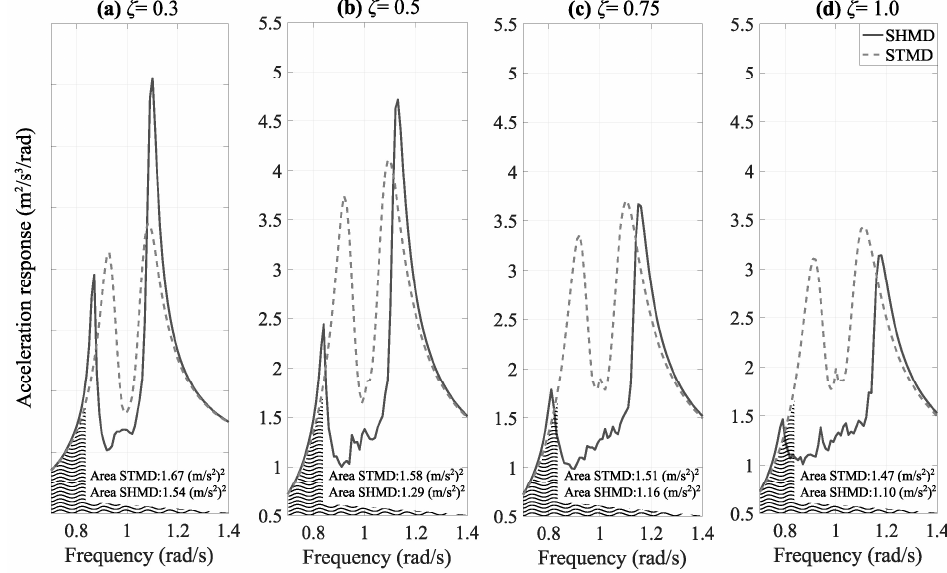
Figure 6. Acceleration response at steady state for damping ratios of ( a ) 0.3; ( b ) 0.5; ( c ) 0.75; and ( d ) 1. Shaded area illustrates average system response.